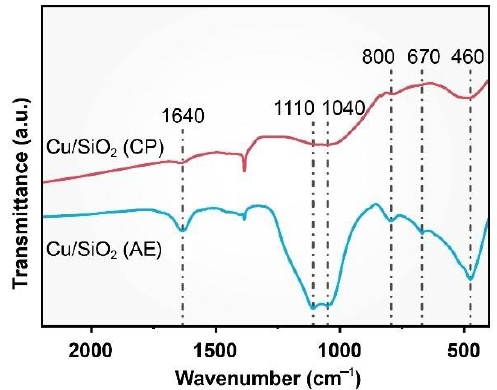
Figure 2. FT-IR spectra of the Cu/SiO 2 (CP) and Cu/SiO 2 (AE) catalysts after calcination.